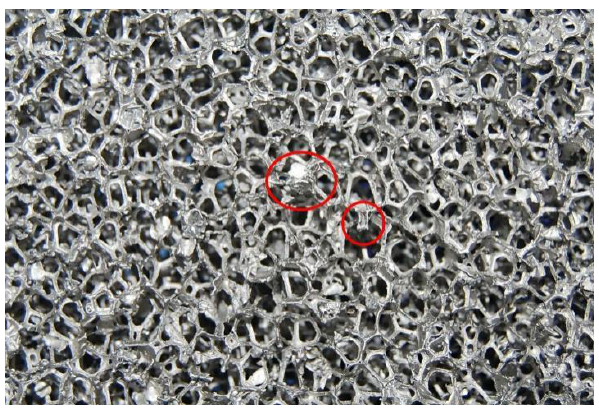
Figure 7. Local view of foam Ni-Fe. Table 2. Mechanical properties of the seven kinds of materials.